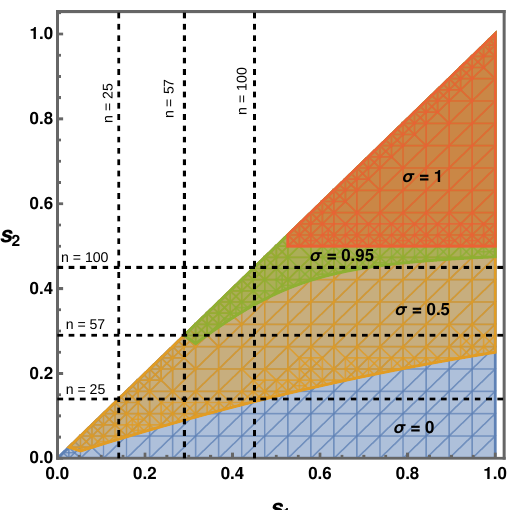
ˆ F (equation A3). Figure A1 – The effect of self-fertilisation and selection on the value of ˆ F In the left panel, we compare the coefficient of inbreeding F (black, dashed line) to for s 1 = s 2 = 0.1 (red line), 0.5 (green line) and 1 (lethal homozygotes, blue line). In the ˆ F right panel we show the value of as a function of the coefficient of selection s H (i.e considering s 1 = s 2 out of convenience) for three values of σ (0.5, 0.95 and 1, in blue, green and red, respectively). The black dotted line is set at s H = 0.5 to highlight the threshold above which overdominance is stable for any value of σ .